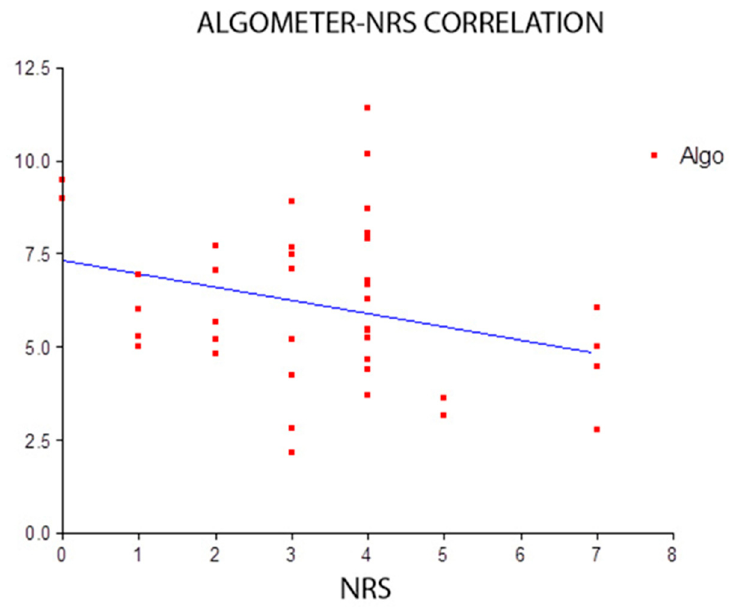
Figure 3. Correlation between Numerical Rating Scale (NRS) scores and algometer measurements, taken at the Posterior Inferior Iliac Spine (PIIS), was not statistically significant ( p > 0.05).